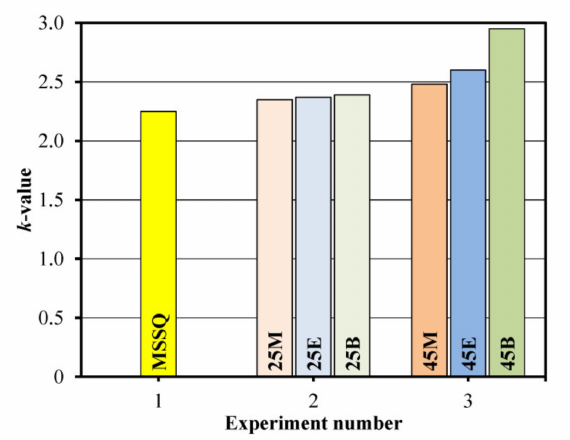
Figure 5. Dependence of the measured k -value (at 100 kHz) on the film composition. The column termed as Experiment 1 corresponds to the methylsilsesquioxane (MSSQ) film prepared from pure methyltrimethoxysilane (MTMS). The samples in Experiments 2, 3 correspond to concentrations of bridging groups’ precursors equal to 25 and 45 mol%, respectively.